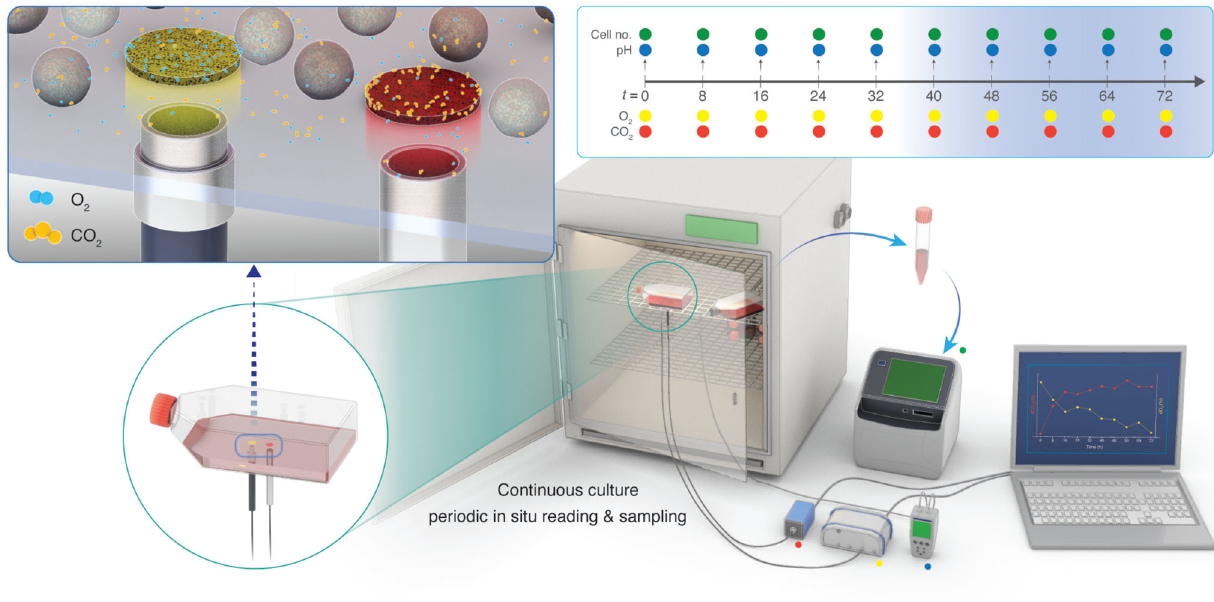
Fig. 1 Non-invasive monitoring of dissolved gases in routine human cell cultures using luminescence-based optical sensors. (Top left inset) simpli fi ed schematic depicting a macroscopic view of the dO 2 (left) and dCO 2 (right) sensor spots af fi xed to the growth substrate (inside of the culture vessel). The fi ber-optic probes transfer light at a speci fi ed wavelength from outside of the vessel to excite the sensor spots, which then emit a fl uorescent signal. These signals are equated to concentration values for dO 2 and dCO 2 . For each cell line assessed, levels of dO 2 and dCO 2 were non-invasively monitored in the culture medium of three identical fl asks using luminescence-based optical sensor spots every 8 h. In parallel, three culture fl asks were sacri fi cially sampled for pH measurements and live-cell counts, yielding a time course of pH, dO 2 , dCO 2 , and live cell counts. (Top right inset) timeline of sampling regime showing the timing of pH (blue dots), dO 2 (yellow) dots, dCO 2 (red dots), and live cell counts (green dots). n = 3 measurements (biological replicates) for each variable at each 8 h